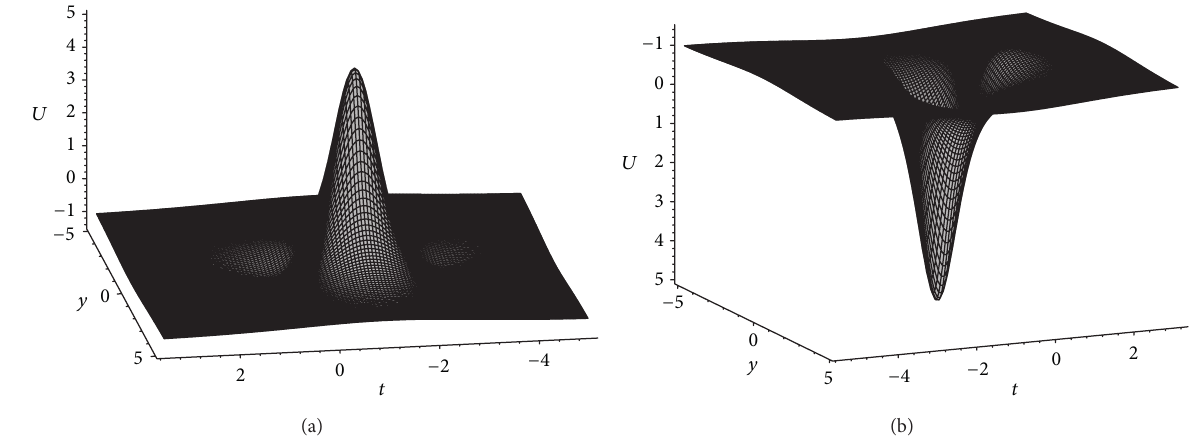
Figure 3: The figure of 𝑈 ( rogue wave as 𝑎 = 𝜔 , 𝑢 0 = 1 , 𝑏 = 2 , 𝜔 = √6/3 , 𝑥 = −1 , and 𝑧 = −2 ytsf )